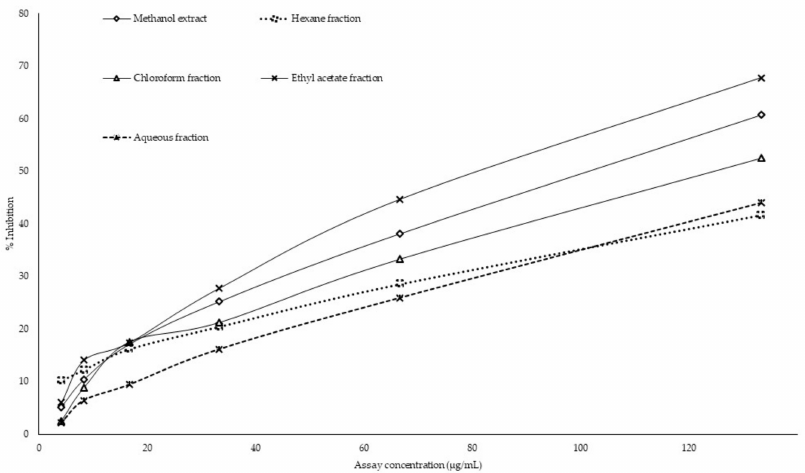
Figure A2. Percentage inhibition of α -amylase by G. edulis methanol extract and its fractions. Results are expressed as mean ± standard deviation ( n = 4).